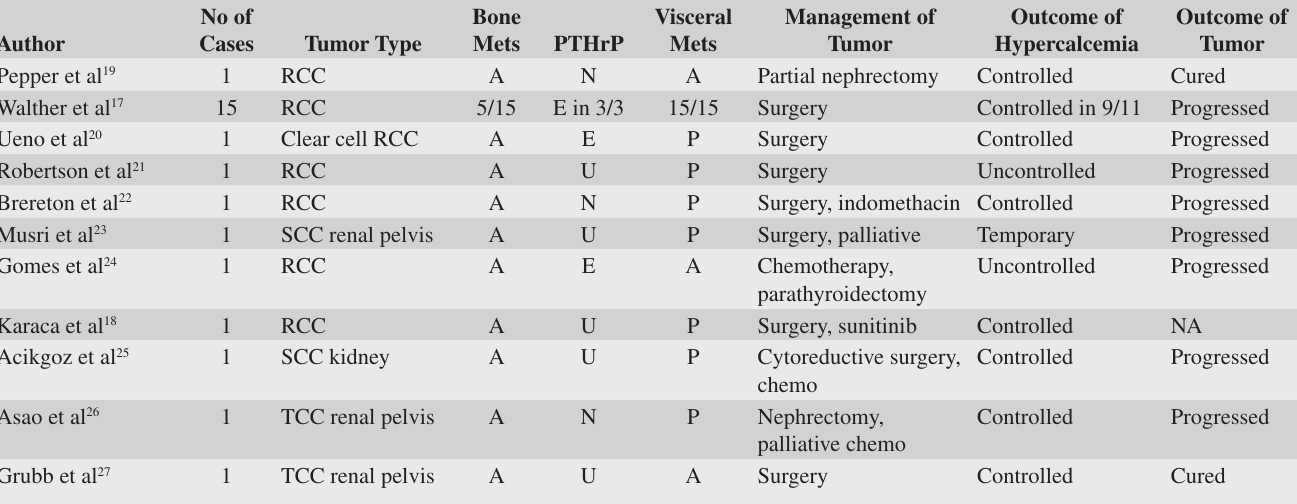
Table 2. Literature on Hypercalcemia in Renal Malignancies